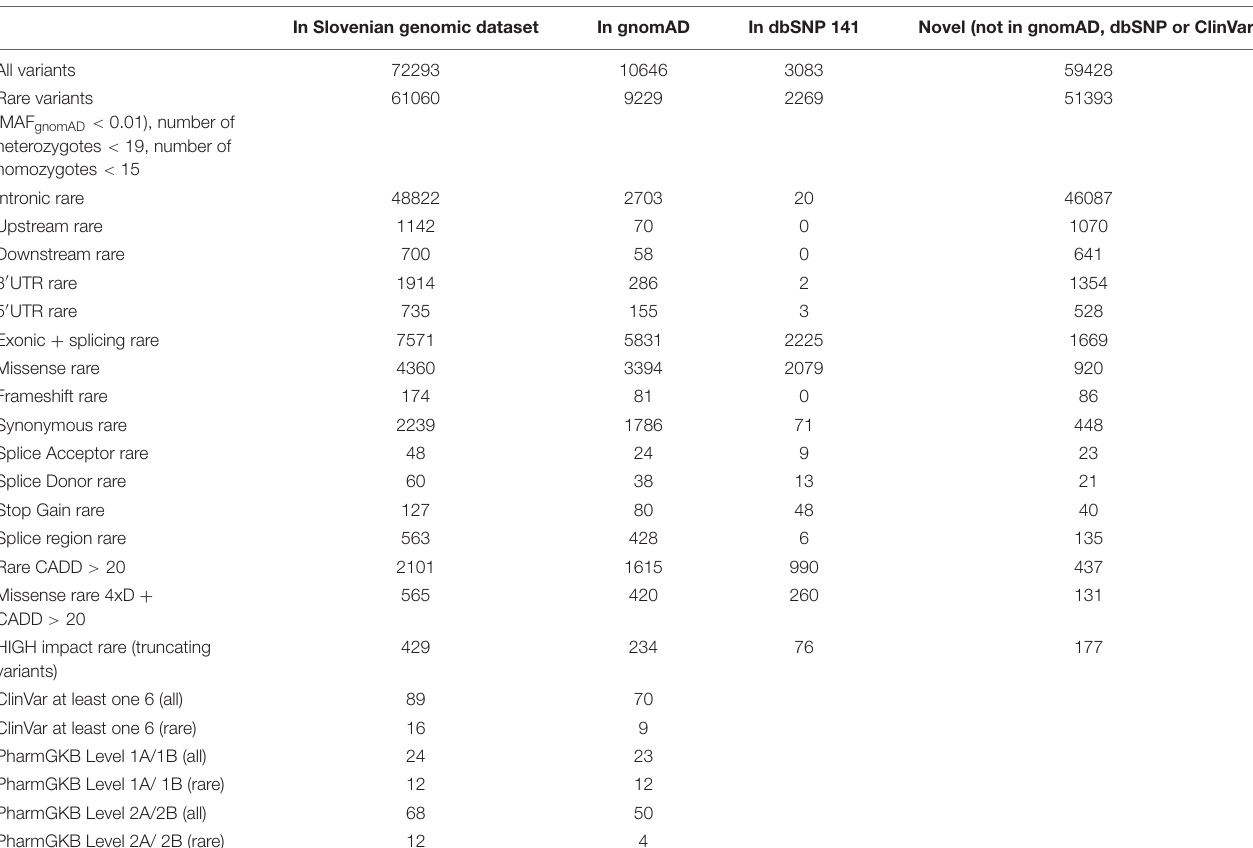
TABLE 1 | SNPEff Variant